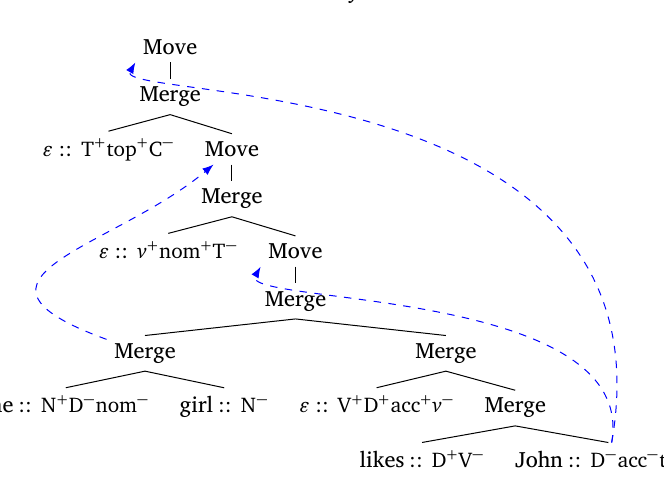
Figure 4: MG derivation tree for John, the girl likes with explicit feature specifications